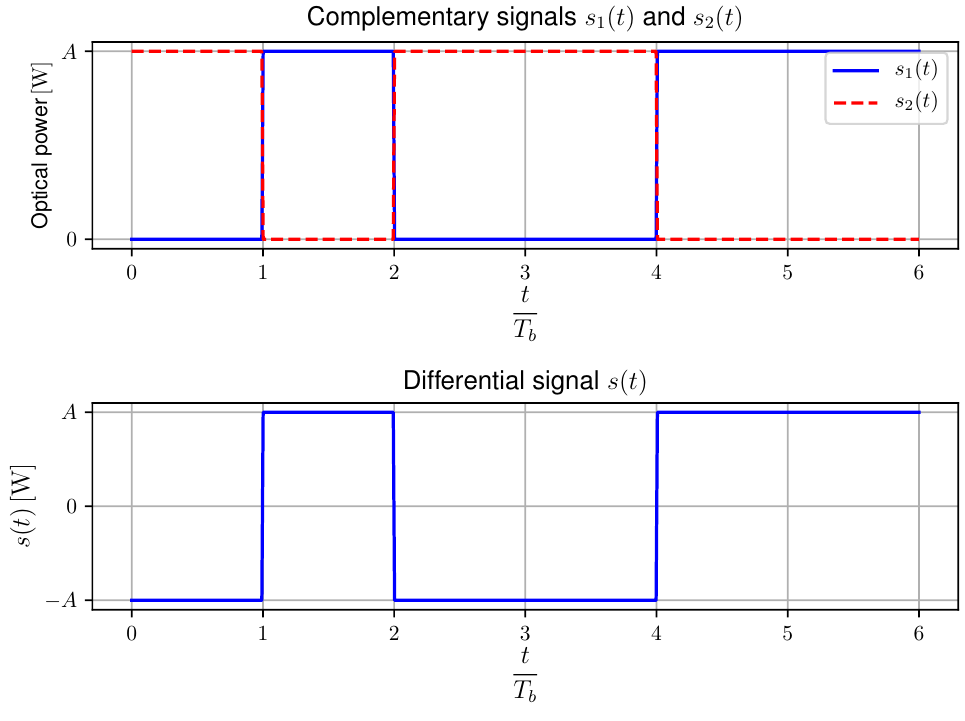
Figure 2. Illustration of ideal complementary transmitted signals s 1 ( t ) and s 2 ( t ) (top) and DC-filtered differential signal s ( t ) (bottom) as defined by Equation (3)